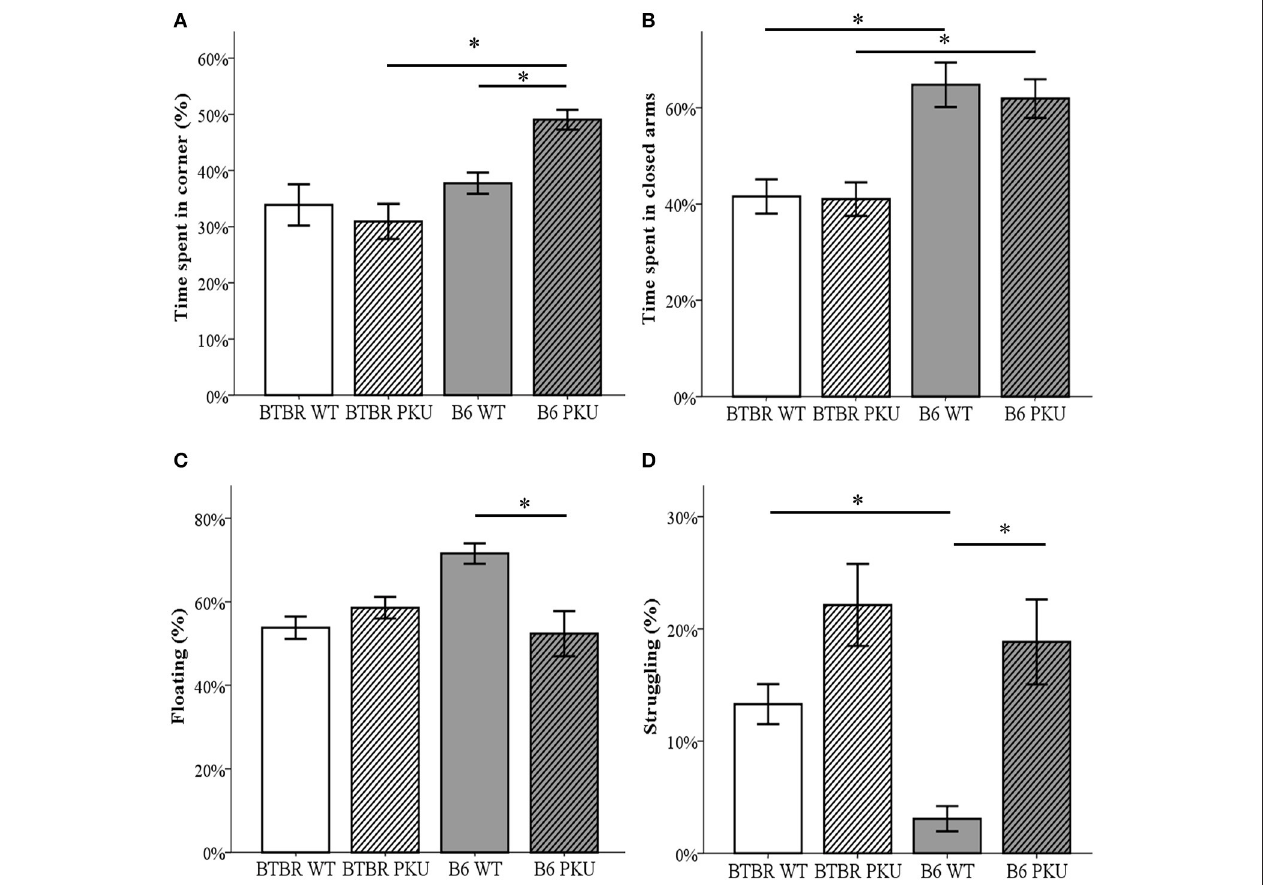
FIGURE 6 | Anxiety- and depressive-like behavior. (A) The time spent in the corners of the open field, the most sheltered areas of the arena. The habituation phase of the NOR was used as open field ( n = 9–10). (B) Time spent in the closed arms of the elevated plus maze ( n = 10). (C) Floating behavior in the forced swim test ( n = 9–10). (D) Struggling behavior in the forced swim test ( n = 9–10). * p ≤ 0.05; mean ± SEM.